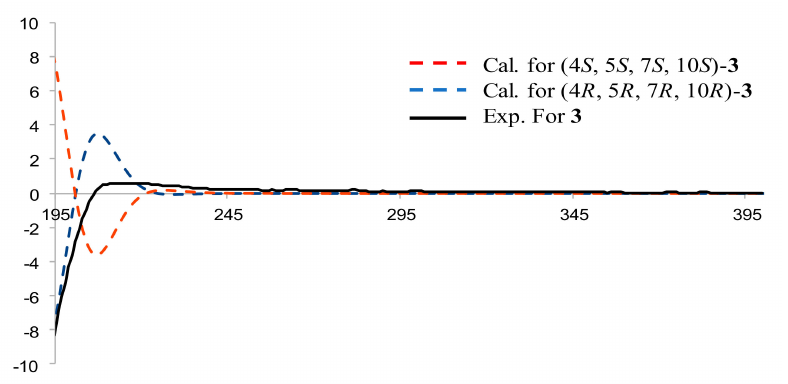
Figure 9. Comparison of the calculated ECD spectrum for (4 R , 5 R , 7 R , 10 R ) − 3 at B3LYP/6-31G(d) level with the experimental spectrum of 3 in MeOH. σ = 0.3 eV, shift = +22 nm.